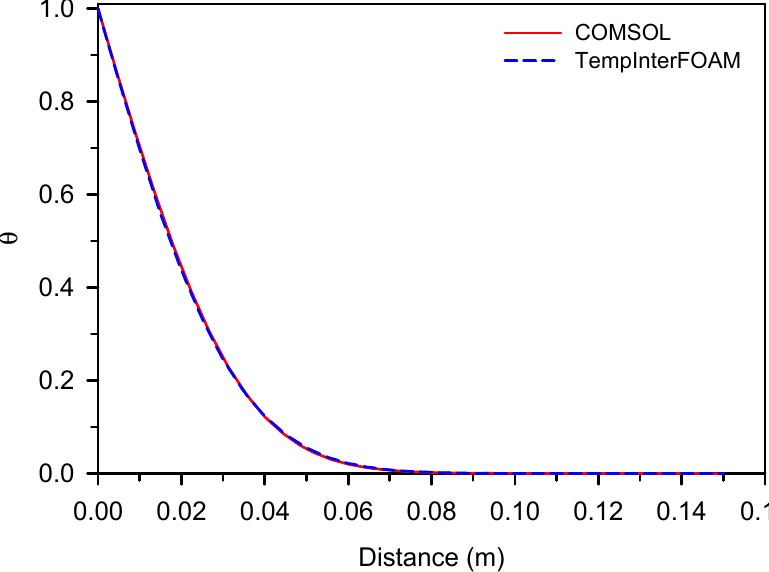
Figure A2. Dimensionless temperature profile along the axis (distance from the bottom wall) resulting from the calculations using OpenFOAM with our new module (TempInterFoam) as well as COMSOL Multiphysics.